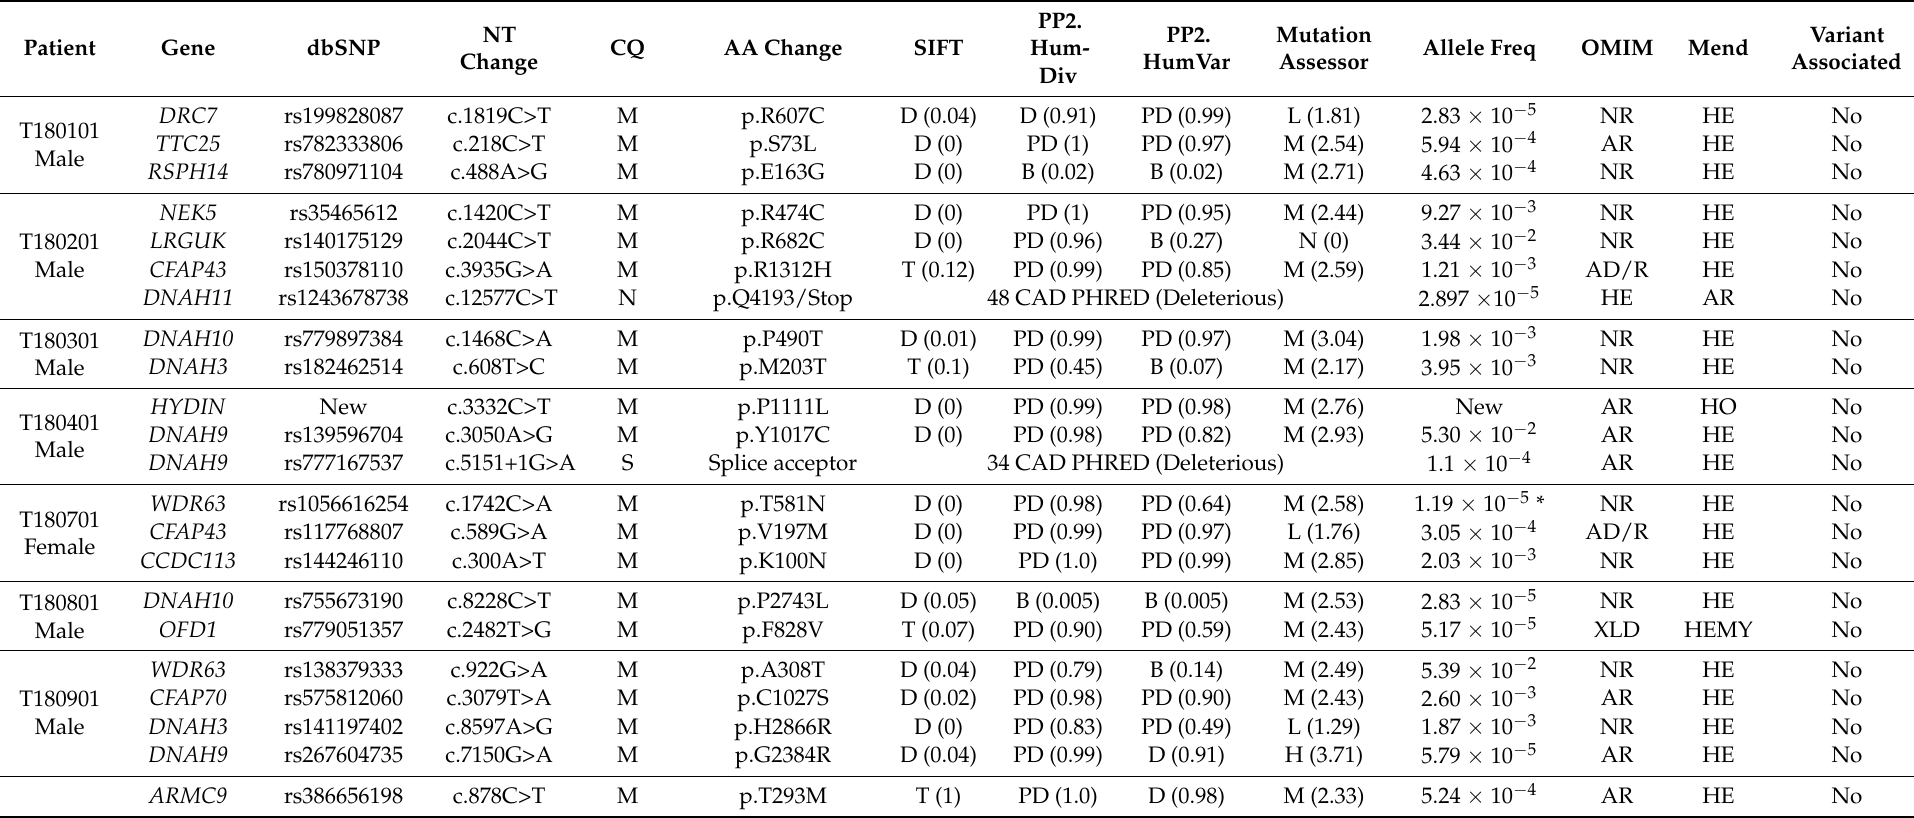
Table 2. Anomalies in motile ciliary genes in TGA patients. Missense, splicing, and nonsense anomalies of ciliary genes found in